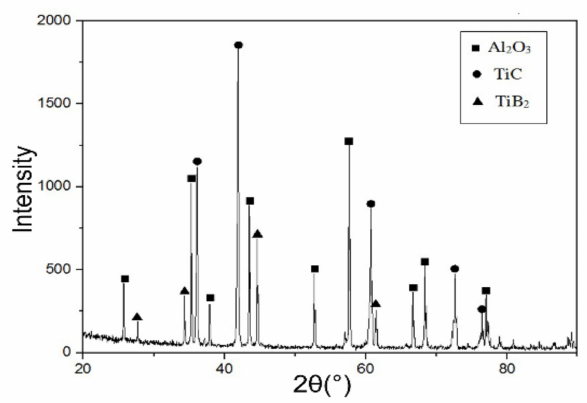
Figure 1. XRD pattern of Al 2 O 3 /TiC/10 vol.% TiB 2 ceramic tool material surface.